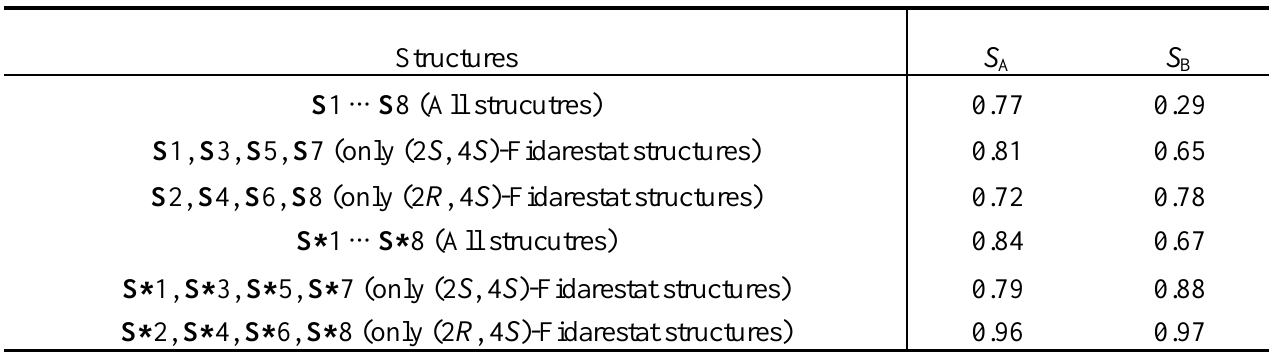
= | Σ V / N |, S = | Σ V / N |, where N is the number of structures and V A 1 B 2 are the vectors. and V 2 and S , as described in the text, calculated for normal and higher A B charged